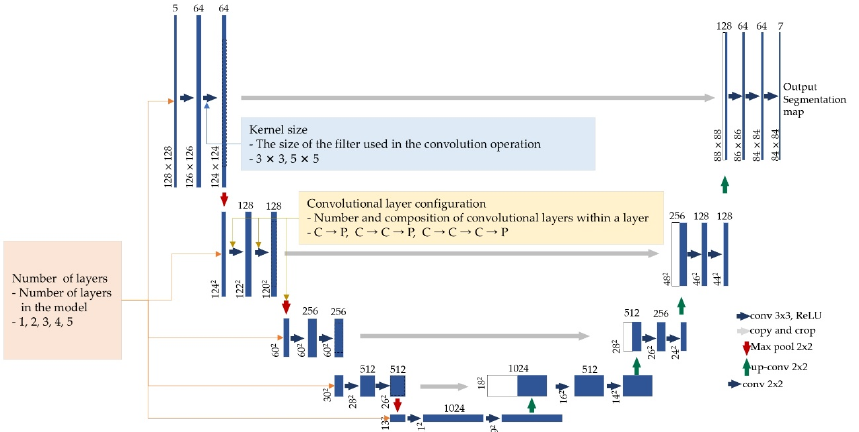
Figure 2. Construction of the deep learning model by adjusting the input image size and hyperpa-